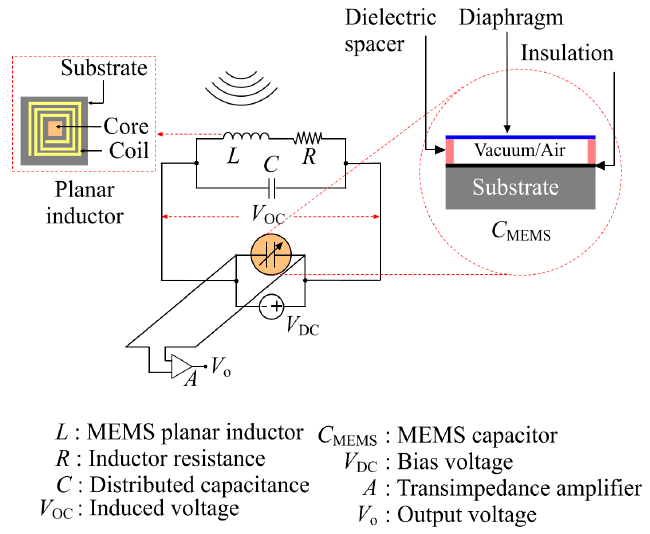
Figure 1. Architecture of the MEMS UWB power sensor. The sensor incorporates a microfabricated Fe ‐ Co ‐ B core planar inductor and a microfabricated vibrating diaphragm variable capacitor. The capacitor generates a frequency ‐ independent output voltage across the transimpedance amplifier in response to an induced voltage across its electrodes by the planar inductor due to an incident UWB signal.